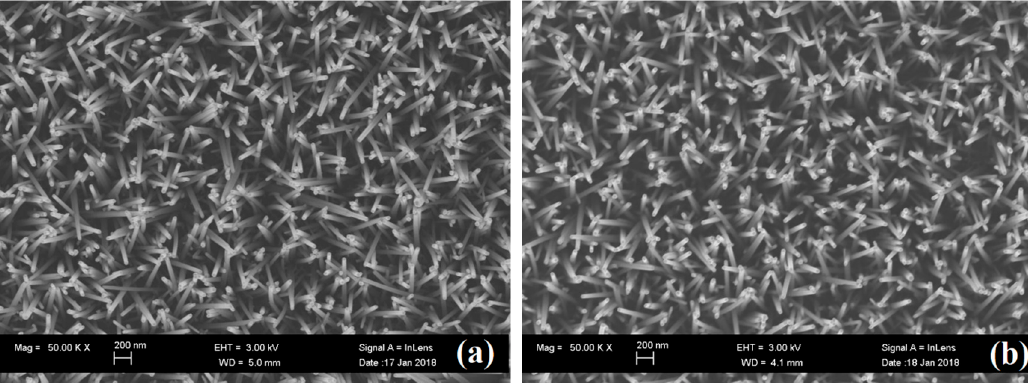
Figure 1. SEM images of ( a ) As growth ZNRs and ( b ) ZNRs annealed with condition of